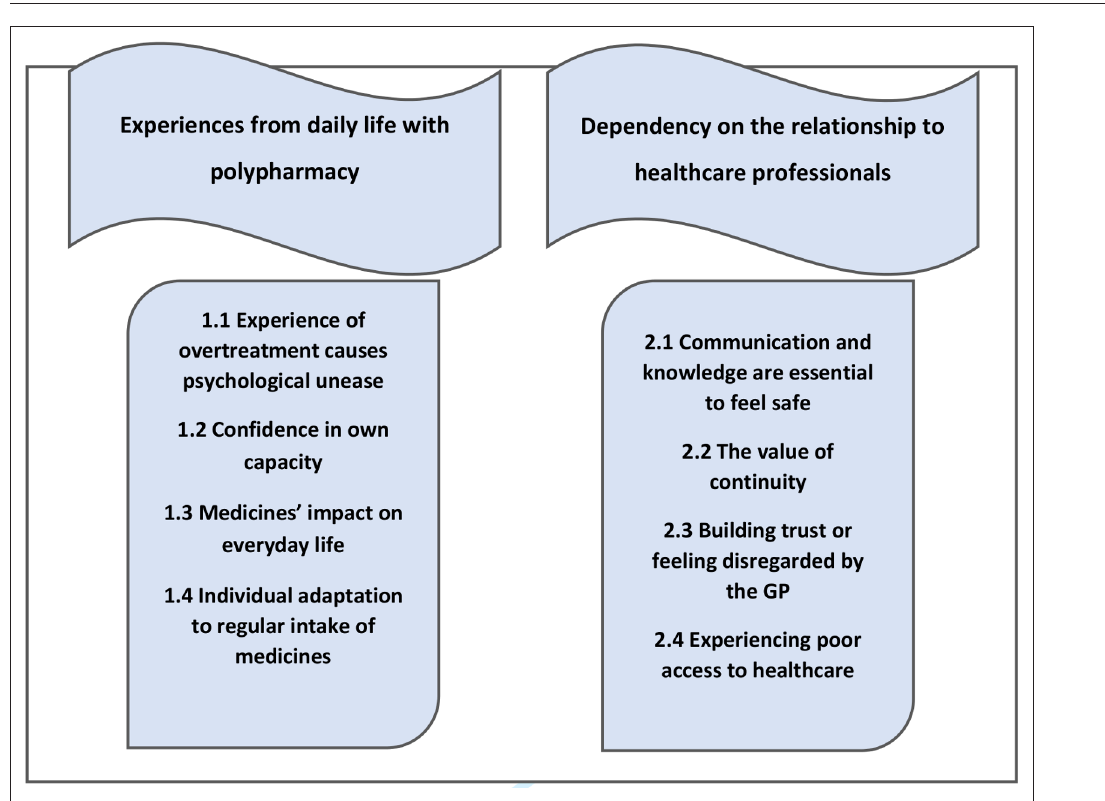
Figure 1 Patients with HC’s experience of polypharmacy: themes 1 and 2 (banners), with categories